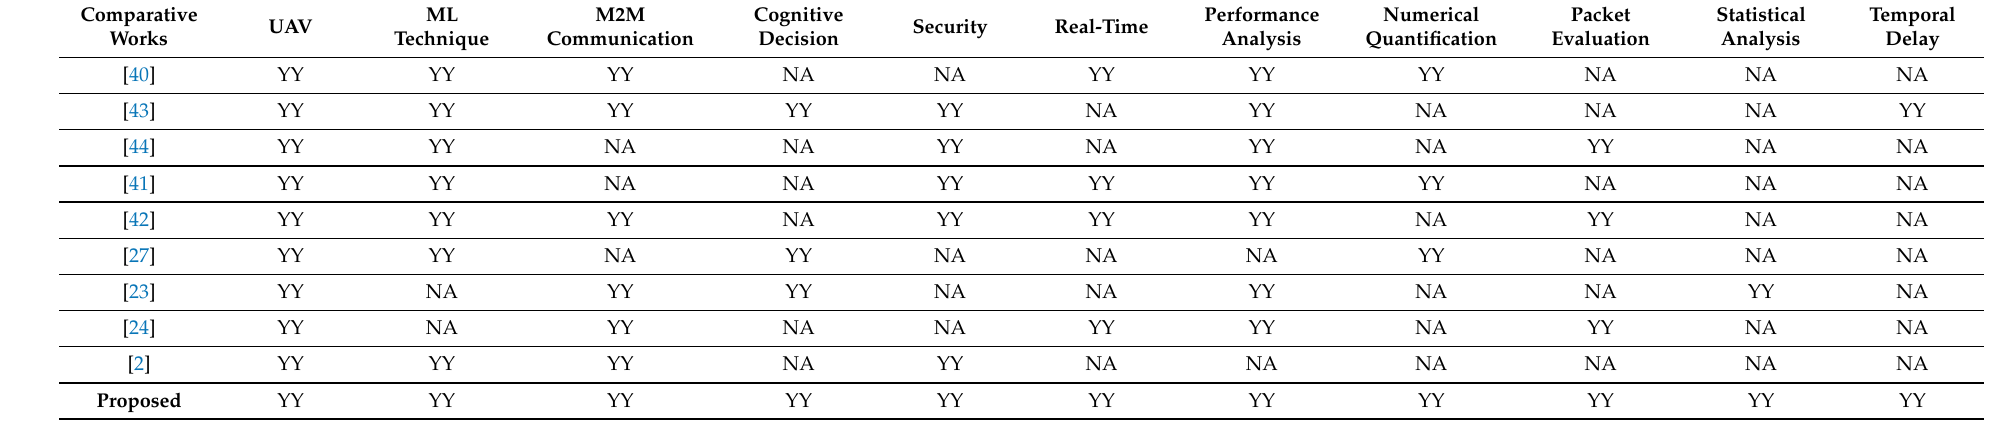
Table 4. Comparative assessment (YY: available, NA: not